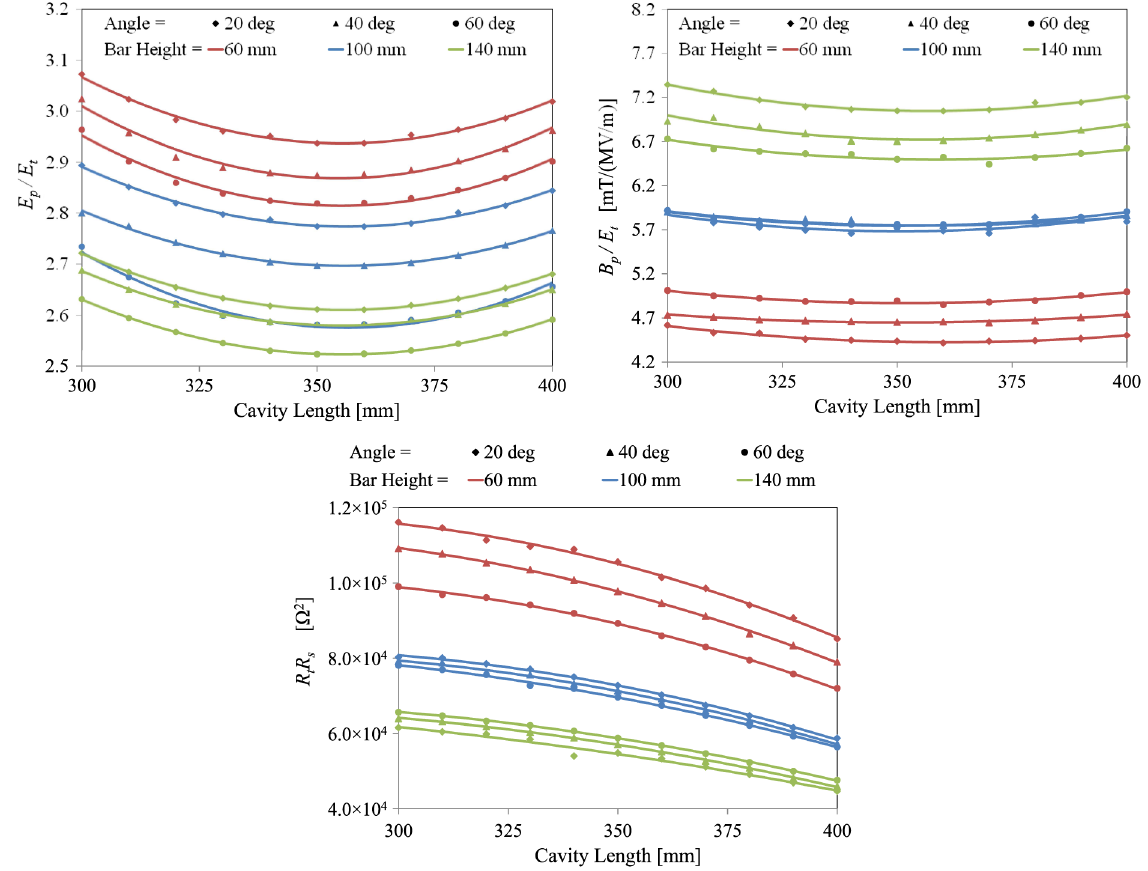
FIG. 24. Ratios of peak surface electric field ( E p ) and magnetic field ( B p ) to the transverse electric field ( E t ) and R t R s with varying cavity length and bar length for different angles and inner bar heights of the trapezoidal-shaped parallel bars [Design (F)].